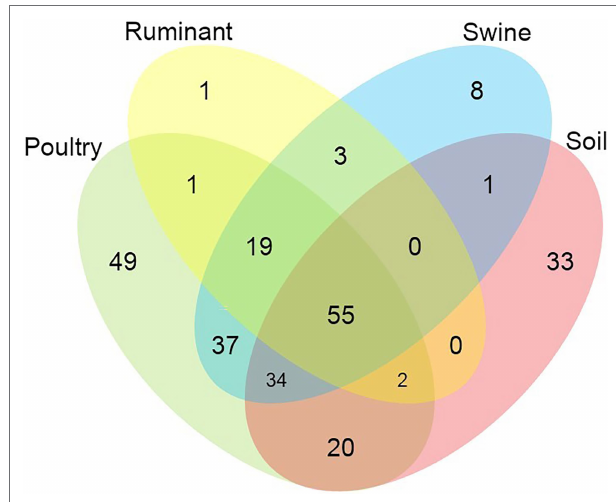
FIGURE 2 | Venn diagram showing the number of shared and unique antimicrobial resistance genes among the analysed microbiomes.